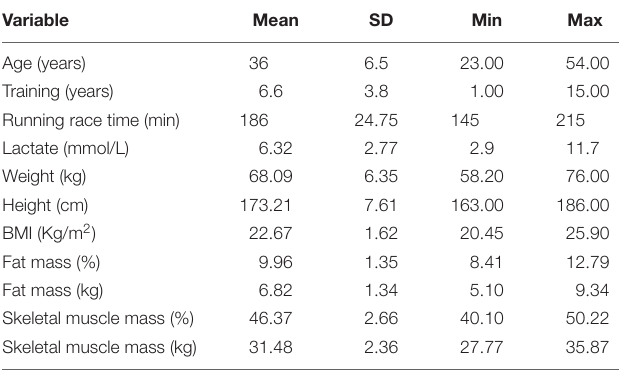
TABLE 1 | Descriptive data for runners and body composition variables.